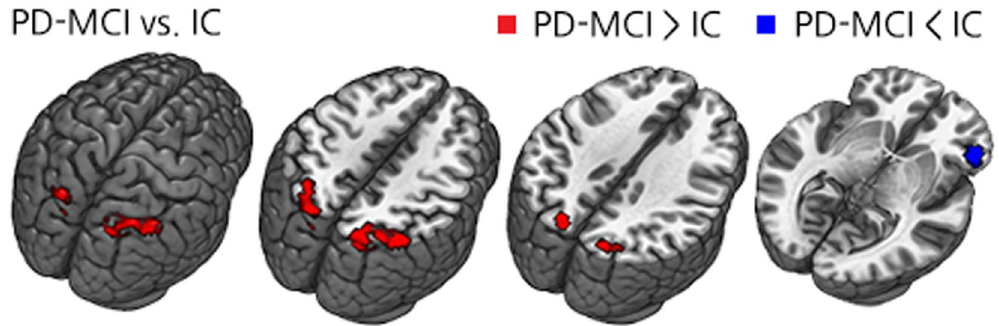
Figure 1. Group comparison of rsFC using the bilateral SI as the seed between the collapsed PD-MCI group and PD-IC group. Abbreviations: PD-MCI = Parkinson’s disease with mild cognitive impairment; PD-IC = Parkinson’s disease with intact cognition; rsFC = resting-state functional connectivity; SI = Substantia